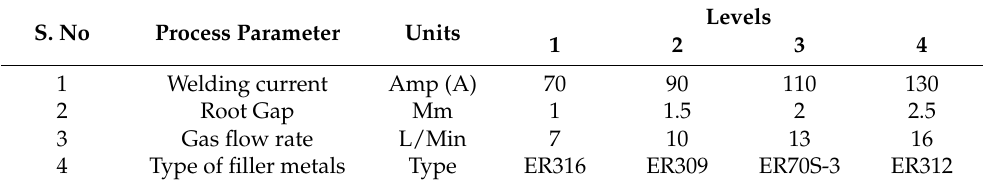
Figure 3. Specimen preparation: ( a ) shear cutting machine, ( b ) stainless steel, ( c ) after shear cutting. Table 3. Selected process parameters and their levels.